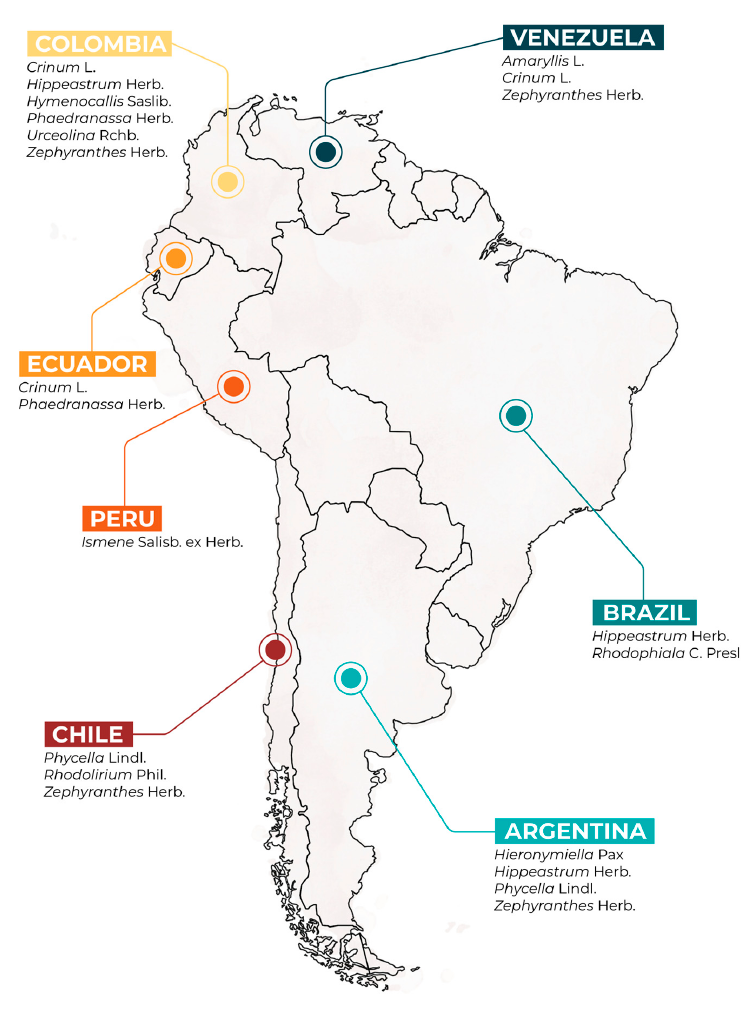
Figure 4. Map of South America showing Amaryllidaceae current genera whose alkaloid profiles and acetylcholinesterase inhibitory activity have been studied recently in this region.